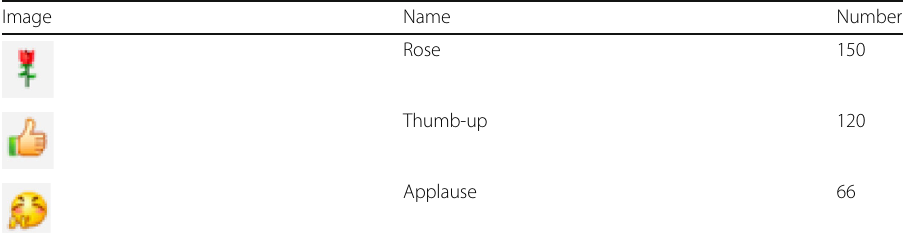
Table 3 Top 3 most frequent Emoji as attitude/emotion signal Image